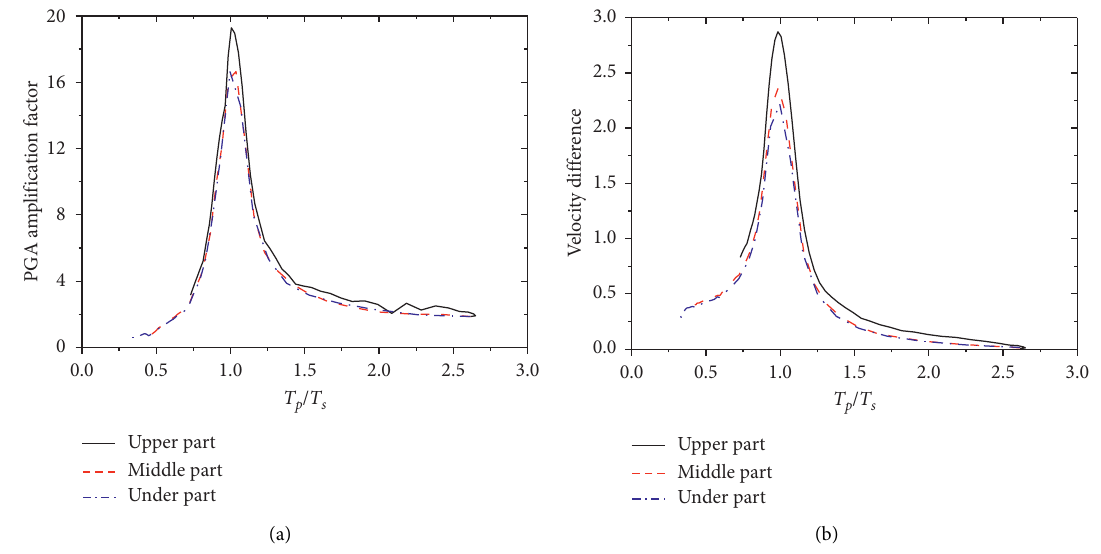
Figure 16: Influence of the interlayer position in the slope on the PGA amplification factor and maximum velocity